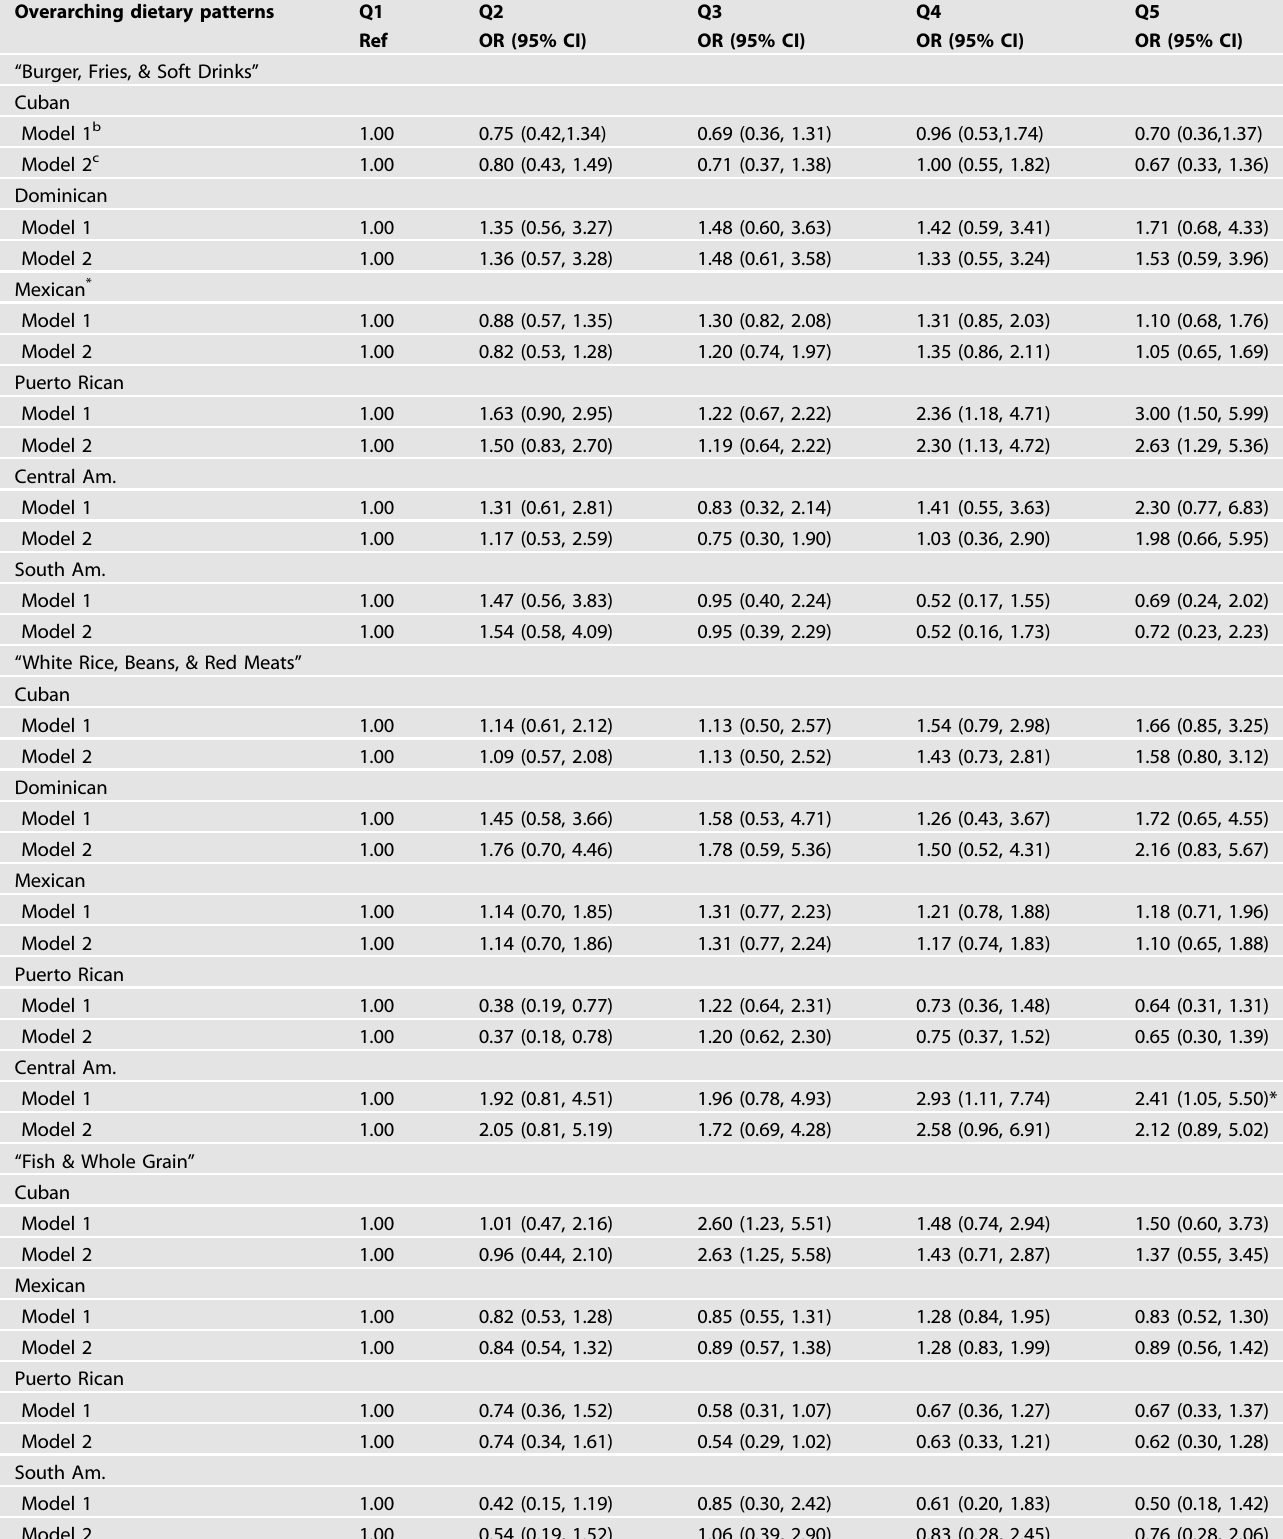
Table 2. Odds ratios (ORs) of 6-year incident diabetes by quintiles of heritage-speci fi c a posteriori dietary patterns for each overarching dietary pattern identi fi ed in HCHS/SOL a